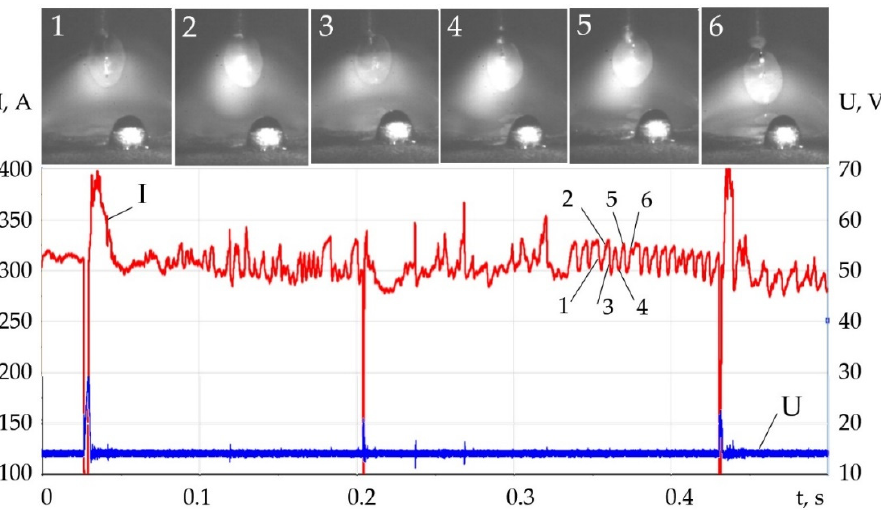
Figure 14. Change in the current and sequence of droplet transfer during melting of 316 L wire of 1.0 mm in the gas mixture, wt.%: 93.6 Ar + 6.4 SF 6 . Time between the frames is 5 ms; 1–6 is a sequence of frames.